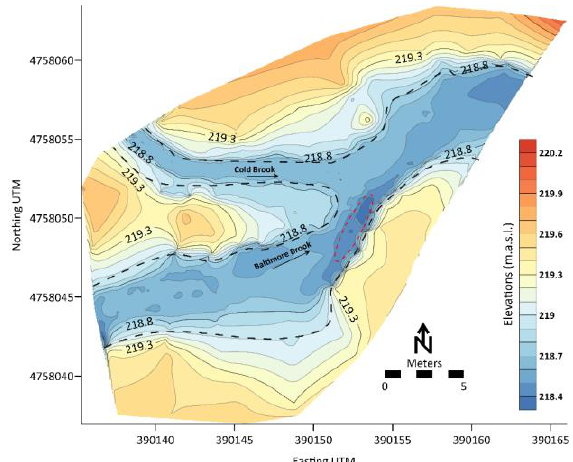
Figure 5. Pictures of the confluence flow during low-flow ( top left , 17 March 2019) and high-flow ( top right , 2 December 2018) conditions, and 3D maps with the hydrodynamic features at a confluence ( bottom ).